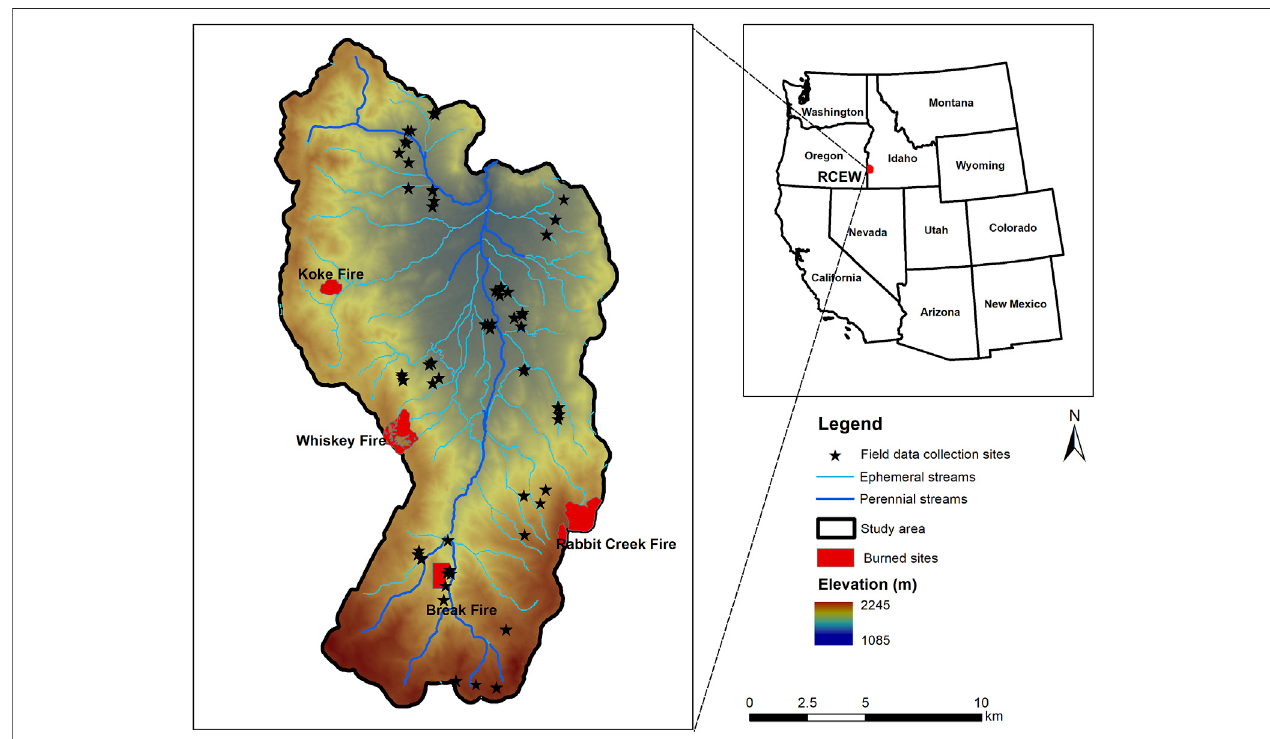
FIGURE1 | Reynolds Creek Experimental Watershed, Idaho, USA, withtopographic gradient and stream network. The black starsrepresent 10 × 10 m fi eld plots across the watershed.